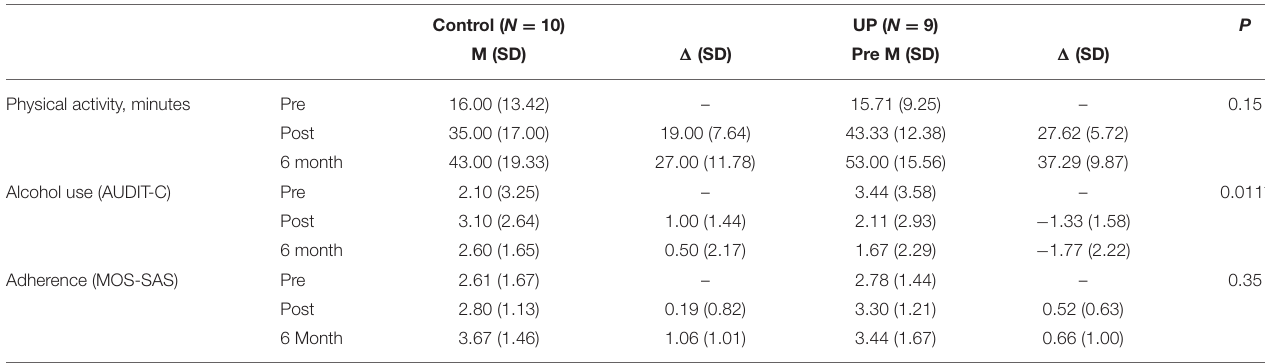
TABLE 4 | Change in health behaviors and adherence for patients randomized to